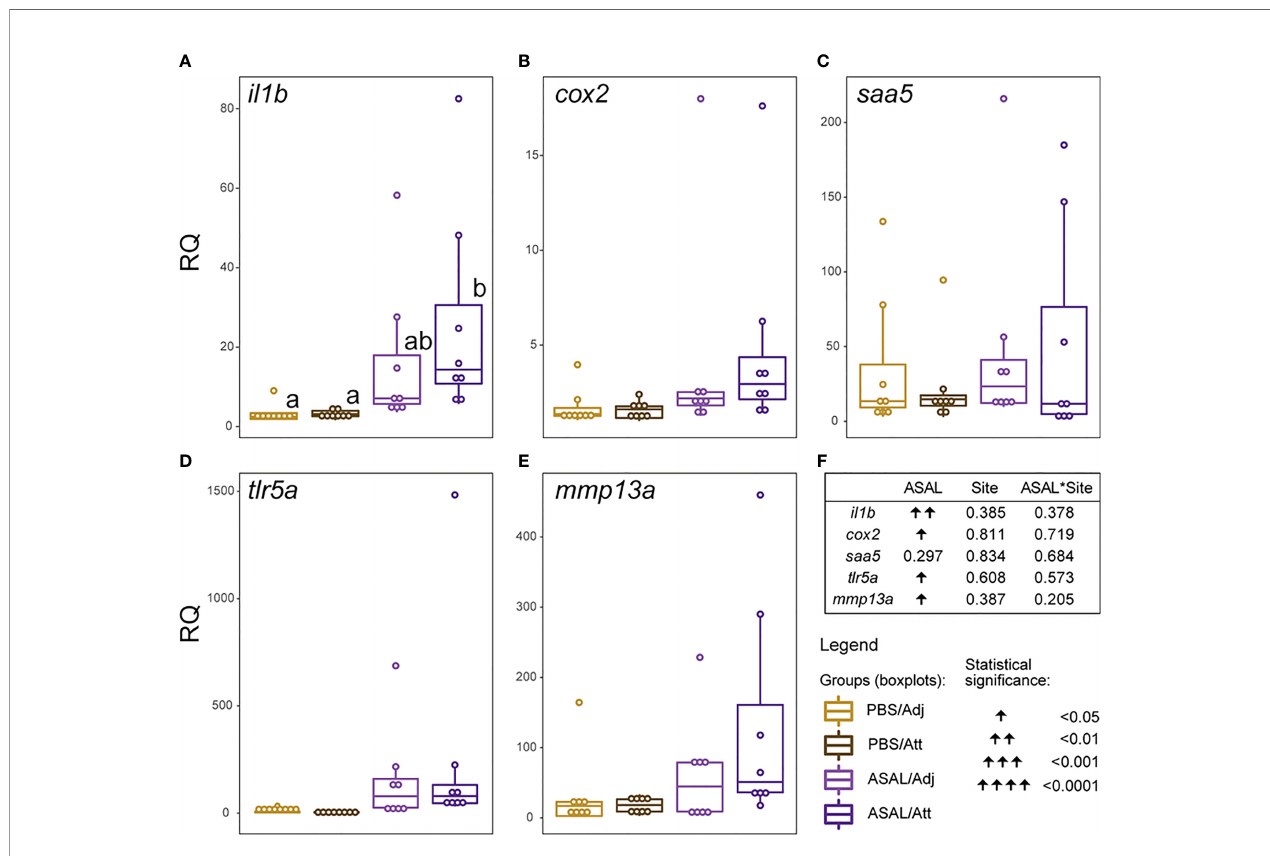
FIGURE 10 | (A – E) Scatter plot/boxplot overlays representing individual/group data of the complementary qPCR experiment examining the differences in the expression levels of a selection of immune-relevant biomarker genes between louse-attachment (Att) and adjacent (Adj) skin sites. Lowercase letters indicate signi fi cant differences between groups, as determined by estimated marginal means. (F) Summary of the results from the generalized linear model (GLM) analysis of the qPCR data. The signi fi cance threshold was p < 0.05 for all statistical